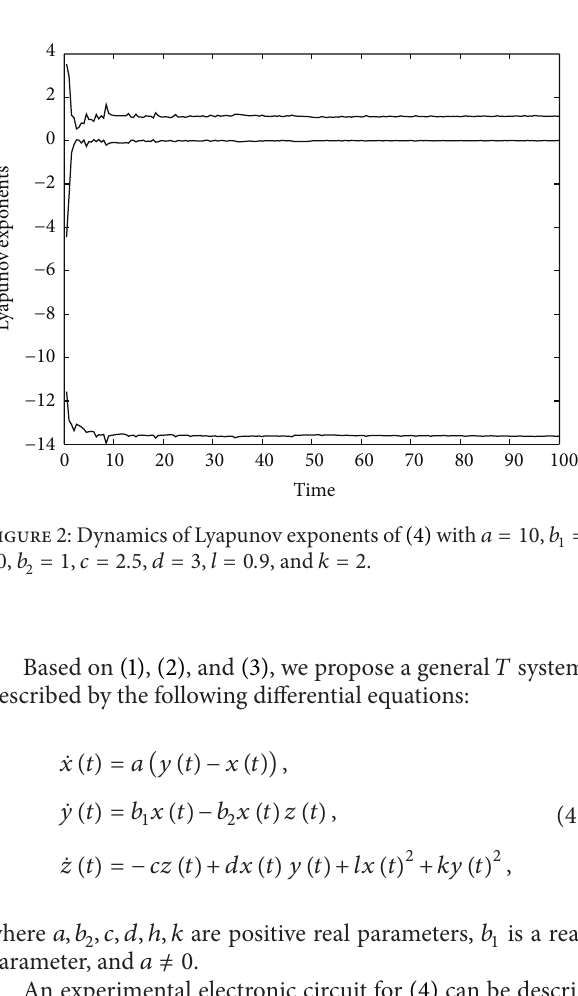
Figure 1: Phase portrait of the chaotic attractor for the general 𝑇 system (4) with 𝑎 = 10, 𝑏 1 = 40, 𝑏 2 = 1, 𝑐 = 2 . 5, 𝑑 = 3, 𝑙 = 0 . 9, and 𝑘 = 2.